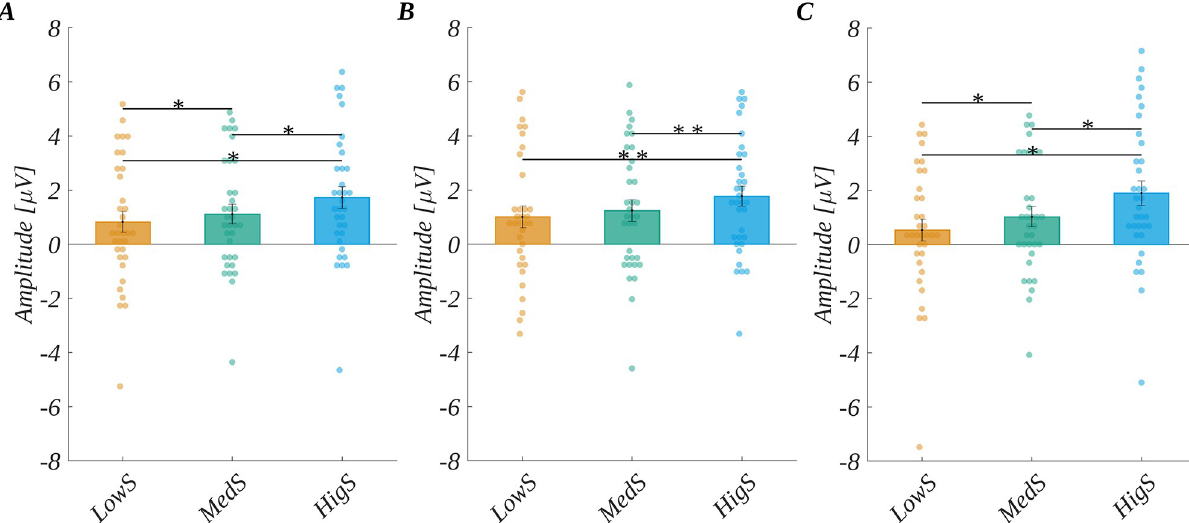
Fig 5. P300 results. The main effect of: subjective significance (A). Interaction between origin and subjective significance: (B) automatic origin and (C) null origin. Bars represent the mean value, error bars SEM, individual dots mark the amplitude for an individual subject in the given condition, black horizontal lines indicate pairs of conditions with significantly different means ( � p < 0.05, �� p < 0.01).